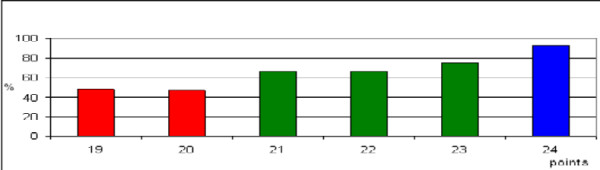
Test group: The total scores in relation to the 12-month survival rate (in%).